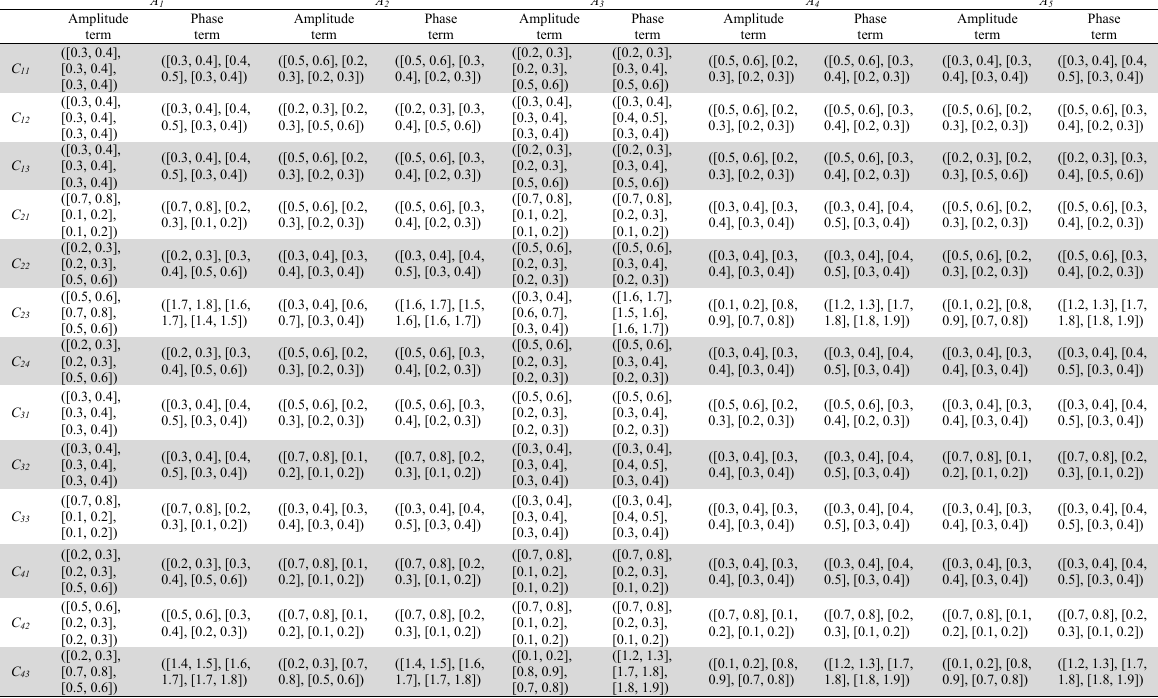
Step 7 : Establish a normalized performance matrix in which two types of criteria (benefit and cost criteria) are converted using formula (11), as shown in Table 10. The normalized matrix after converting the benefit and cost criteria A